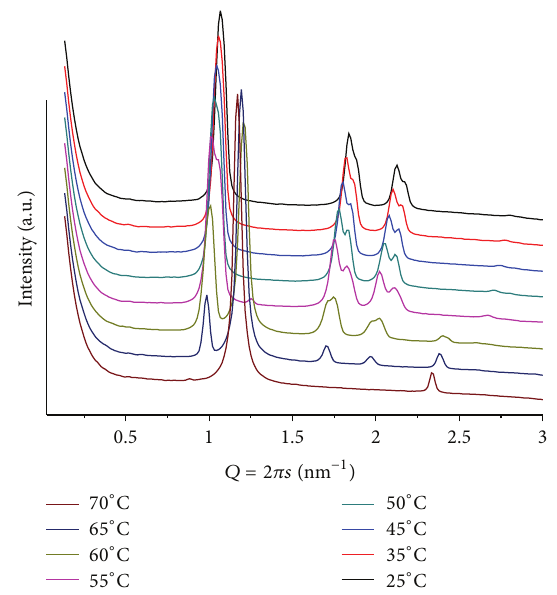
Figure 11: SAXS patterns at different temperatures for POPE/ BANHQ, mr = 100 and pH = 4